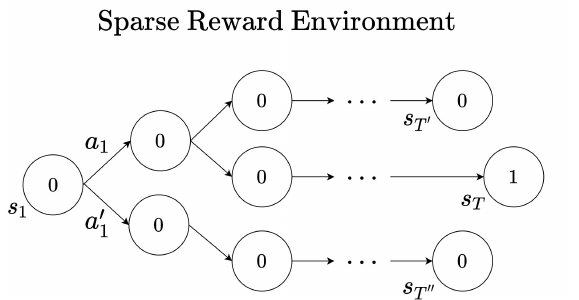
Figure 4. Example of trajectory in the environment with sparse